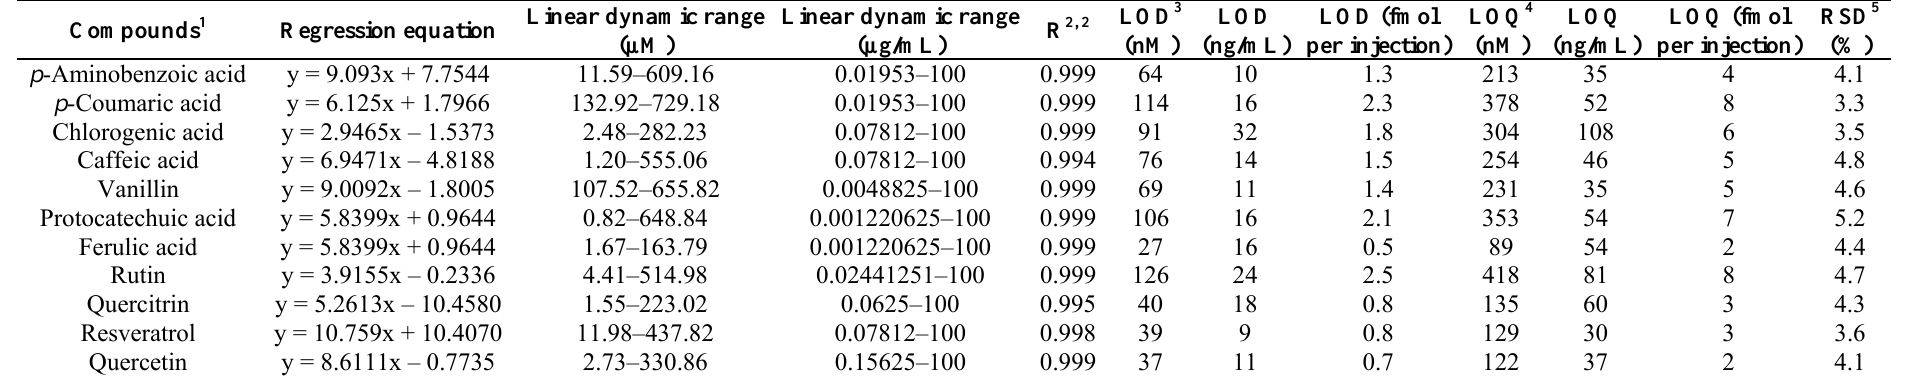
Table 2. Analytical parameters of electrochemical